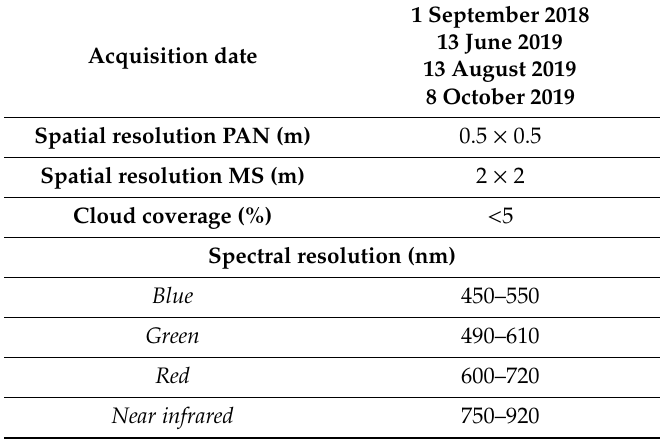
Table 1. Technical characteristics of high-spatial-resolution (HSR) images used for this